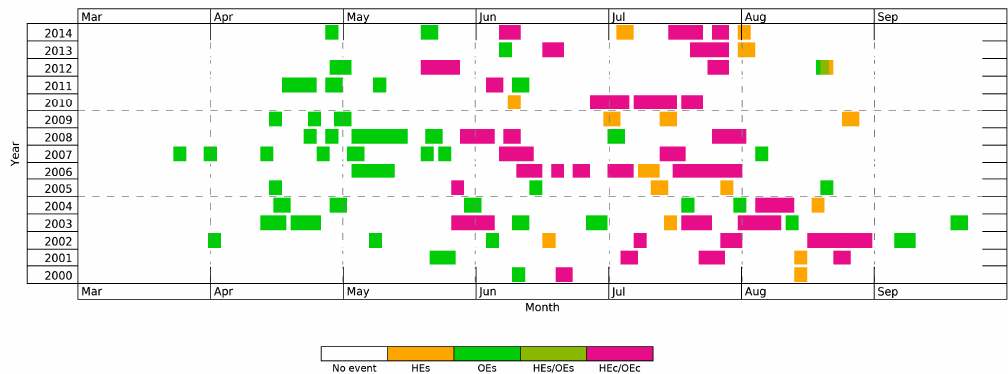
Figure 8. Temporal occurrences of HEs (T mean > 22 °C, orange), OEs (MDA8 > 100 µg m − 3 , green), and corresponding coupled events (HEc/OEc, purple) in Berlin from 2000 to 2014. Overlapping days of HEs and OEs that are not classified as coupled events are marked in olive-green.